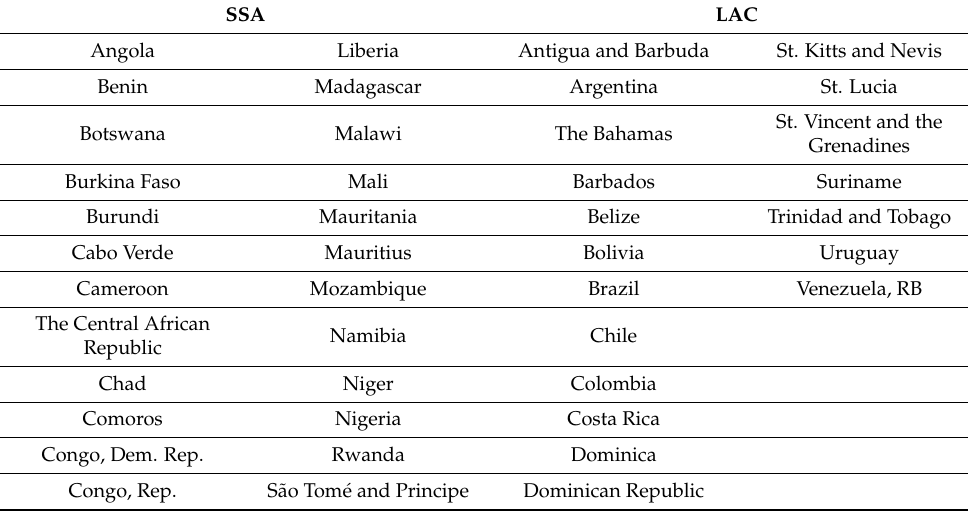
Table A1. Sub-Saharan African and Latin American and Caribbean